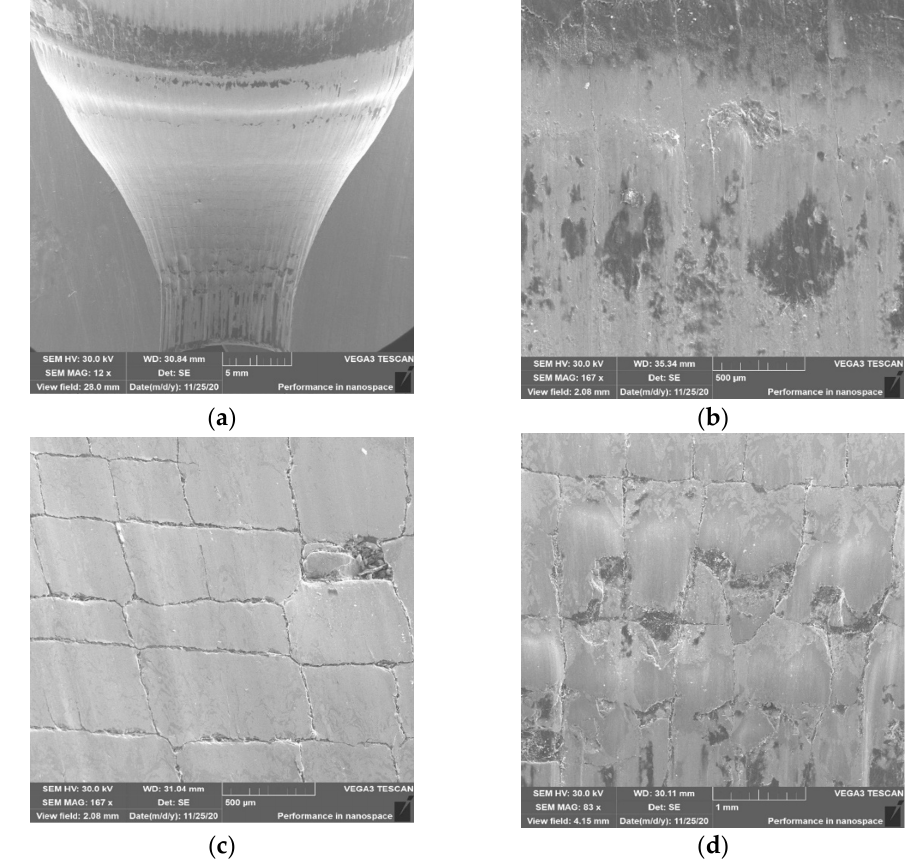
Figure 14. SEM analysis for tool 2: ( a ) cavity; ( b ) area in zone 1; ( c ) area in zone 2; ( d ) area in zone 3.